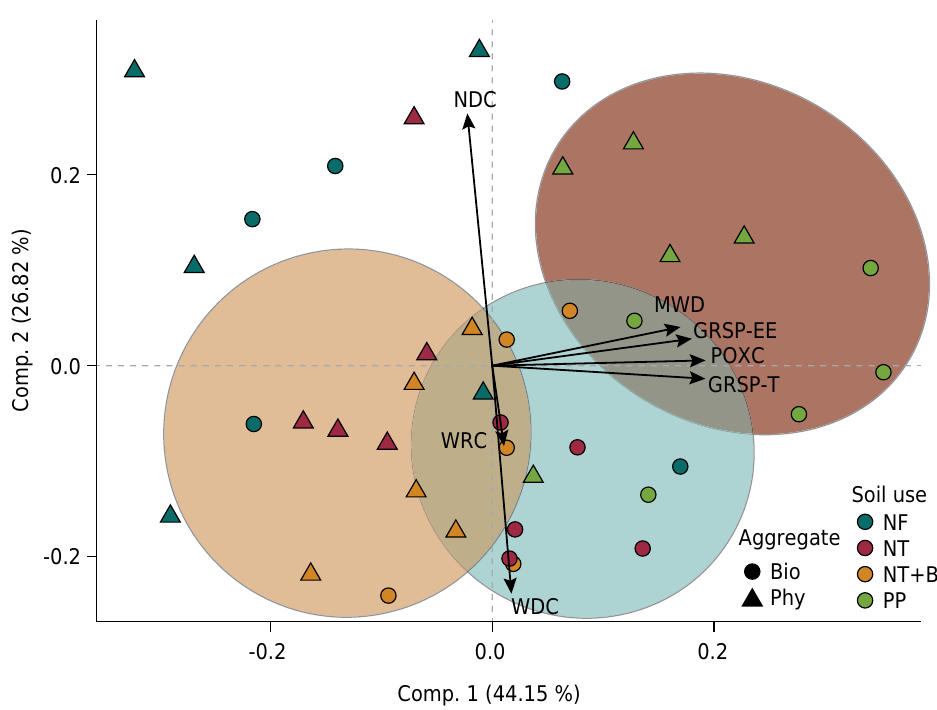
Figure 3. Principal component analysis integrating the aggregation state and the organic fractions associated with the stability of biogenic (Bio) and physicogenic (Phy) aggregates from areas under management systems in the 0.00-0.05 m layer, subtropical region of Brazil. PP: Permanent pasture; NT: No-tillage system; NT+B: No-tillage + Brachiaria system; NF: Atlantic Forest biome vegetation; MWD: mean weight diameter; WDC: water-dispersible clay; WRC: water-re-flocculable clay; NDC: non-dispersible clay; POXC: labile organic carbon; GRSP-EE: easily extractable glomalin; and GRSP-T: total glomalin.